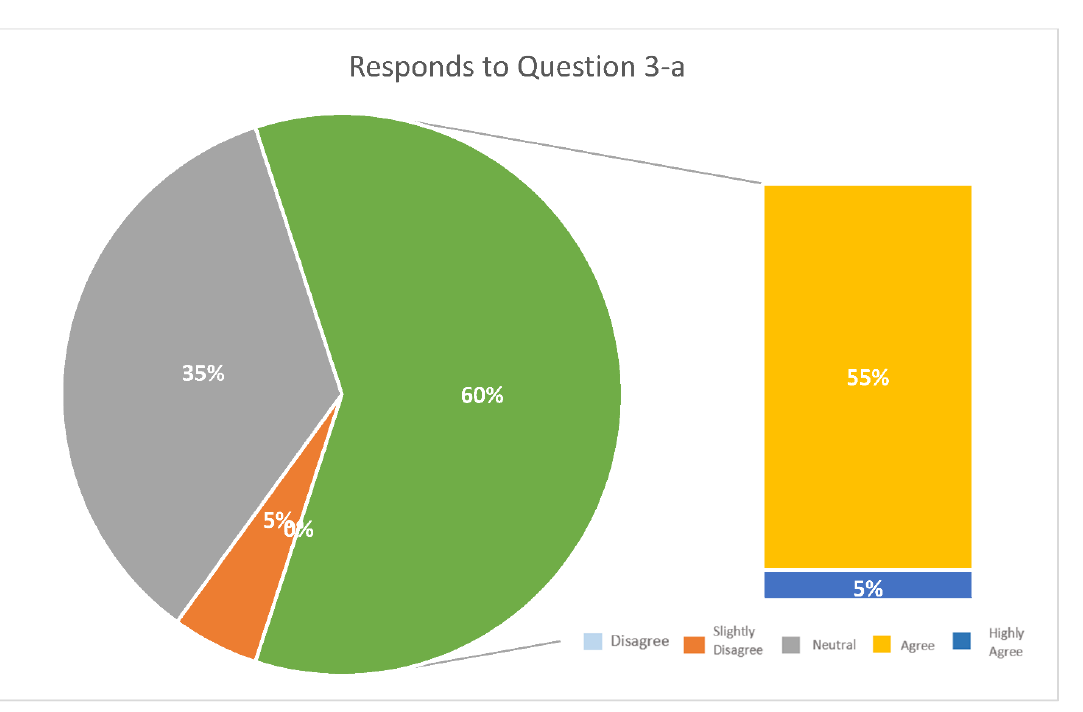
Figure 10. Responses to Question 3-a.